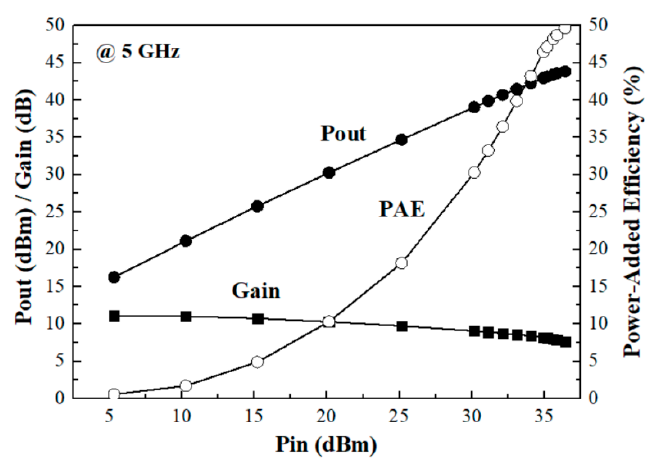
Figure 11. Output power, power gain, and power-added efficiency (PAE) across the input power at 5 GHz.